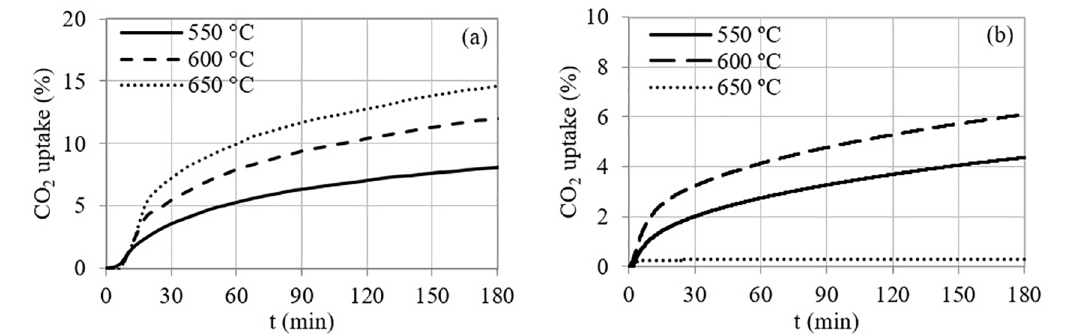
partial pressures of 1.0 atm (a) and 0.15 atm 2